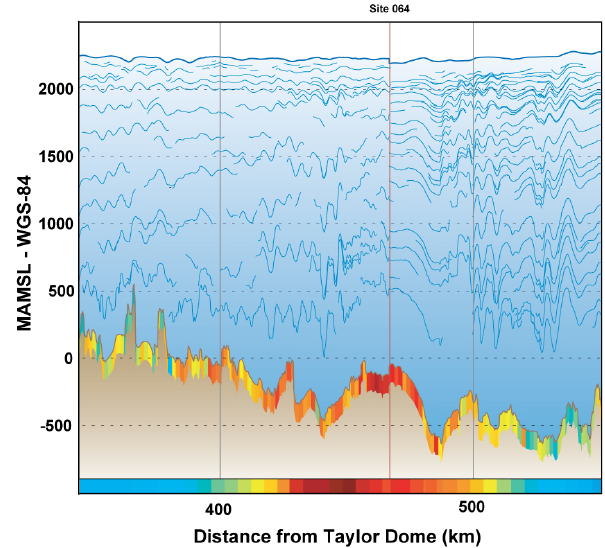
Fig. 4. Basal reflectivity, topography and prominent internal lay- ers from a portion of the traverse in the northern Byrd Basin cor- responding to higher velocities. Balance velocities are also shown across the bottom of the figure for comparison with reflectivity. Ve- locity colors are scaled to the range of balance velocities, approxi- mately 0–70m/a. Areas of high basal reflectivity (warm colors) are independent of bed roughness and ice thickness, and correspond closely with velocity. Basal reflectivity color scale is in dB, the same scale used in Figs. 1 and 2. The apparent discontinuity at site 06-4 corresponds to a short segment oriented perpendicular the rest of the traverse to circumvent a region of